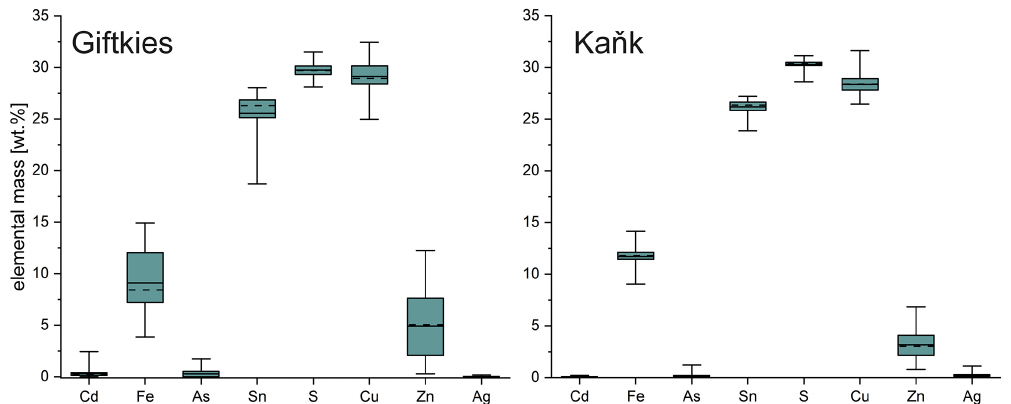
Figure 2. Box plot of the compositional range of stannite from Giftkies ( n = 157) and Kaˇnk ( n = 88) (average: solid line; median: dashed line; box: 25th–75th percentile; range: minimum–maximum (includes outliers)).